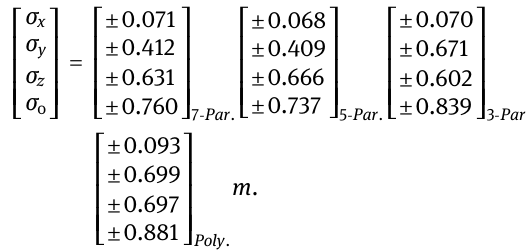
Figure 10 con fi rms that the polynomial model resulted in the highest Δ X error among various addressed transfor - mation approaches, whereas the three - parameter method had a comparable value of 67% of the points, while the